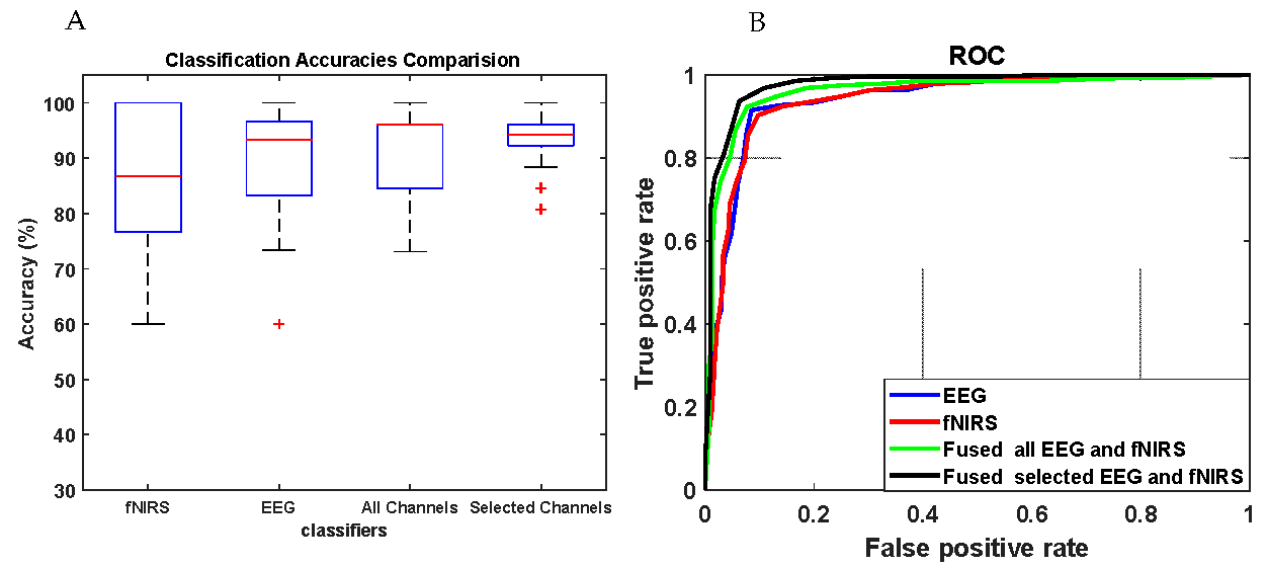
Figure 11. ( A ) Classification accuracies of ankle joint movements based on the single and bi-modilties; the (+) symbols represent the outliers’ values. ( B ) ROC for EEG, fNIRS, and integrated EEG and fNIRS.